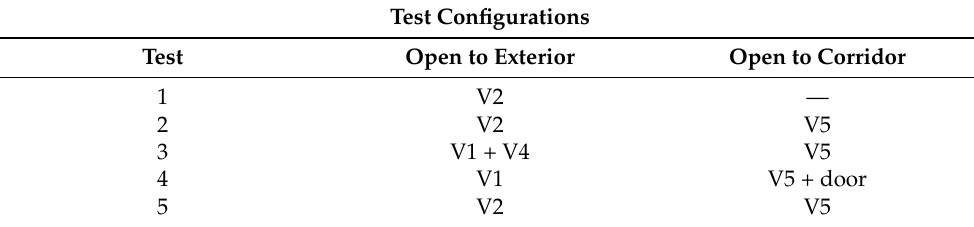
Table 1. Controlled tests configurations. Windows are labelled as described in Figure